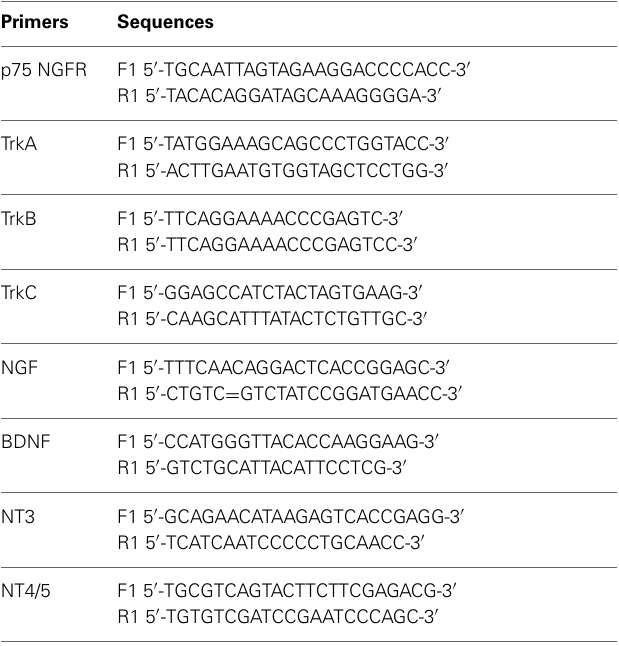
Table 1 | Summary of primers